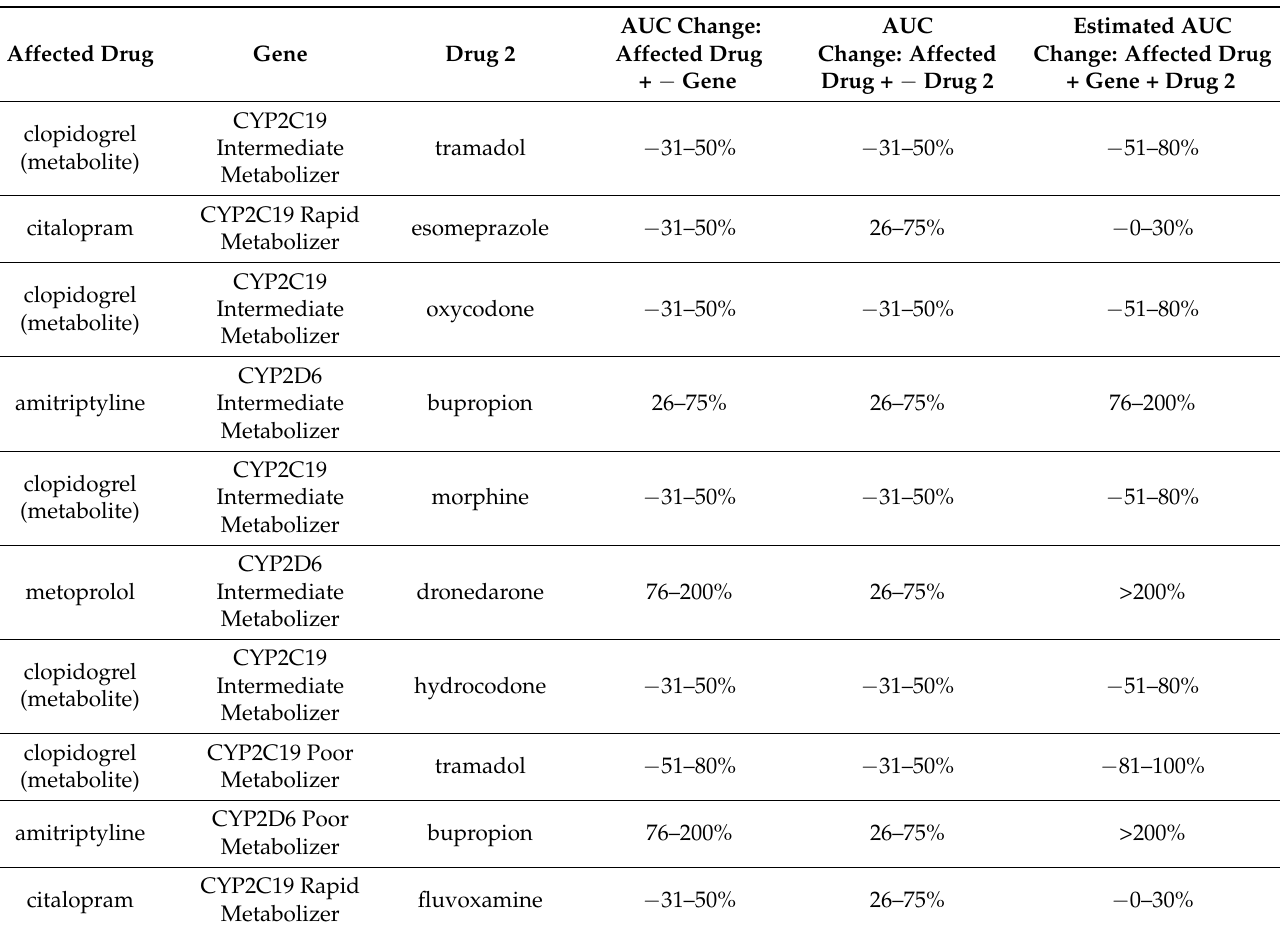
Table 4. Ten most common EADDGIs (i.e., phenoconversion) with cumulative impact on